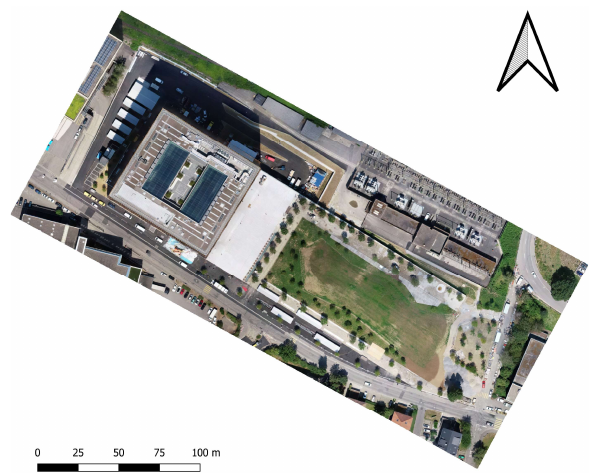
Figure 3. Campus Muttenz with the main building (north-west) and its park (from the centre towards south-east)